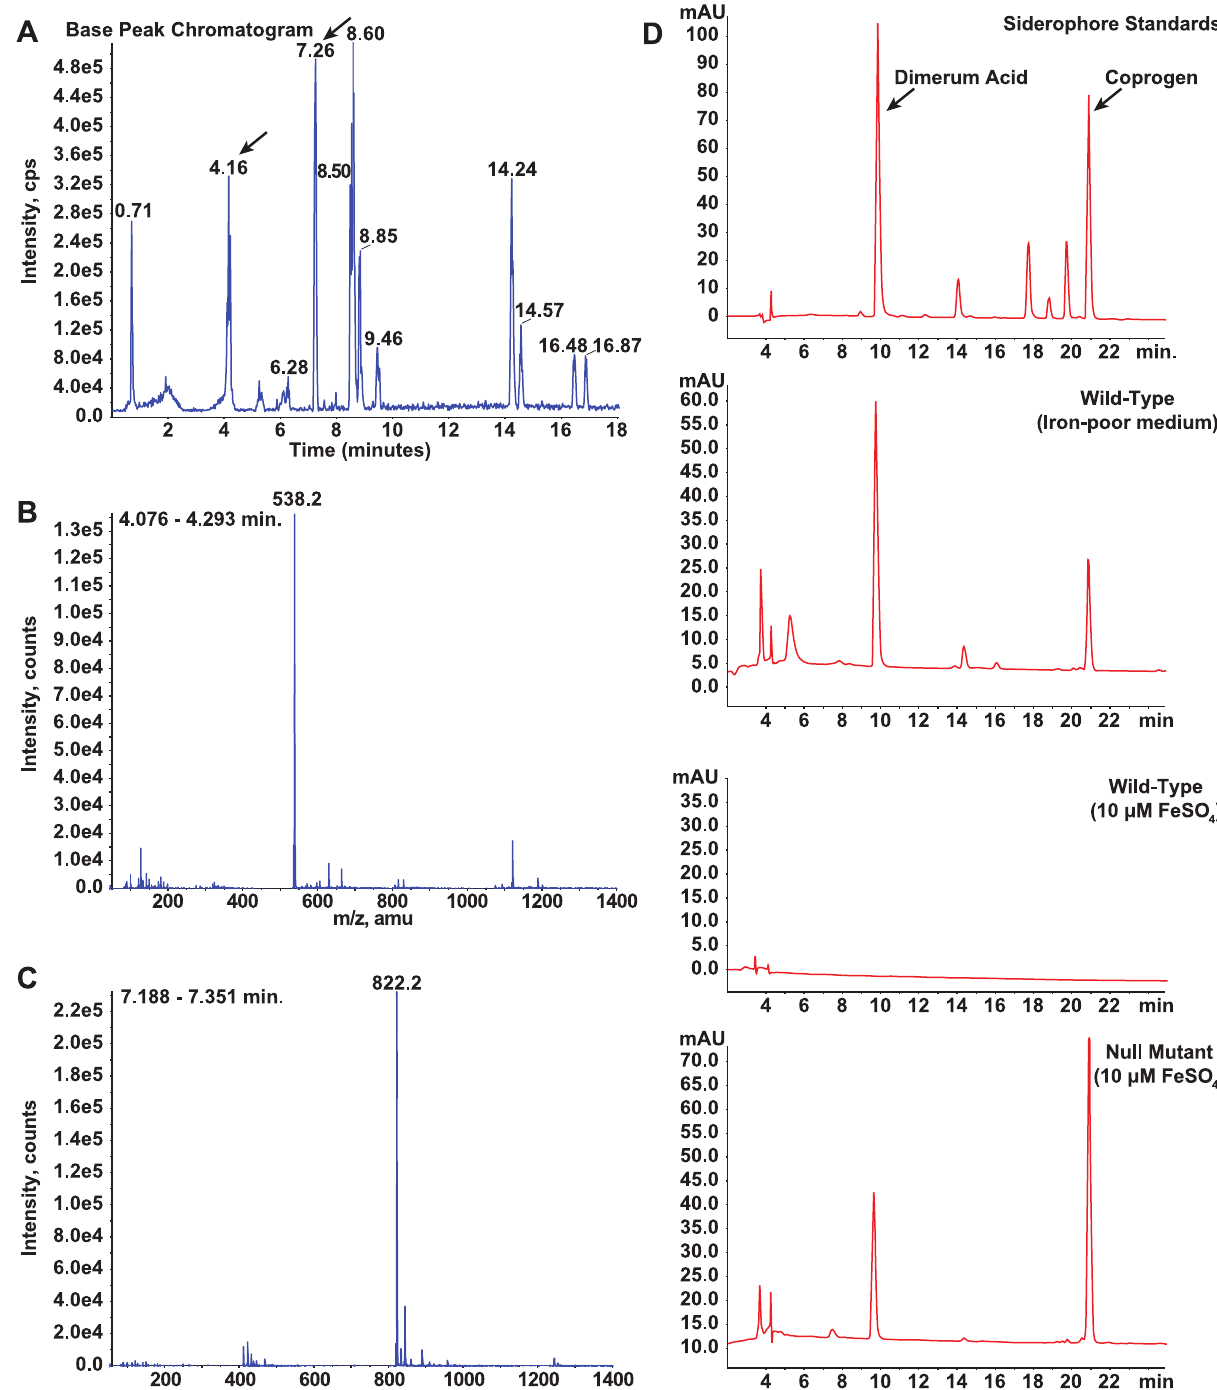
Figure 7. Identification and characterization of siderophores in B.dermatitidis . ( A-C ) Culture supernatant harvested from wild-type B. dermatitidis grown under iron-poor conditions was applied to a column packed with XAD-2 resin. Following a water wash, compounds bound to the resin were eluted with methanol and analyzed by LC/MS. The chromatogram revealed the presence of several compounds in the eluate (A). Analysis of these compounds using mass spectroscopy revealed that two of the peaks (4.16 and 7.26 minutes) had masses consistent with dimerum acid (538.2) and coprogen (822.2), respectively (B, C). ( D ) Culture supernatants harvested from wild-type B. dermatitidis grown under iron-poor and iron- replete conditions were compared to siderophore standards using HPLC. During conditions of iron-limitation, the wild-type isolate produced and secreted dimerum acid and coprogen. When iron was abundant, no siderophores were detected. In contrast, the null mutant SREB D produced and secreted dimerum acid and coprogen under iron-replete conditions.